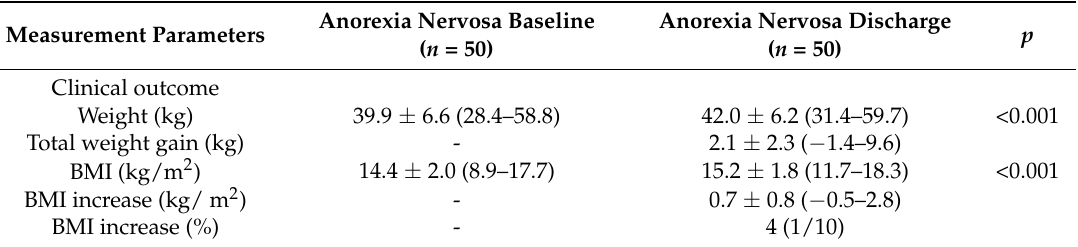
Table 3. Clinical outcome parameters of patients with anorexia nervosa.